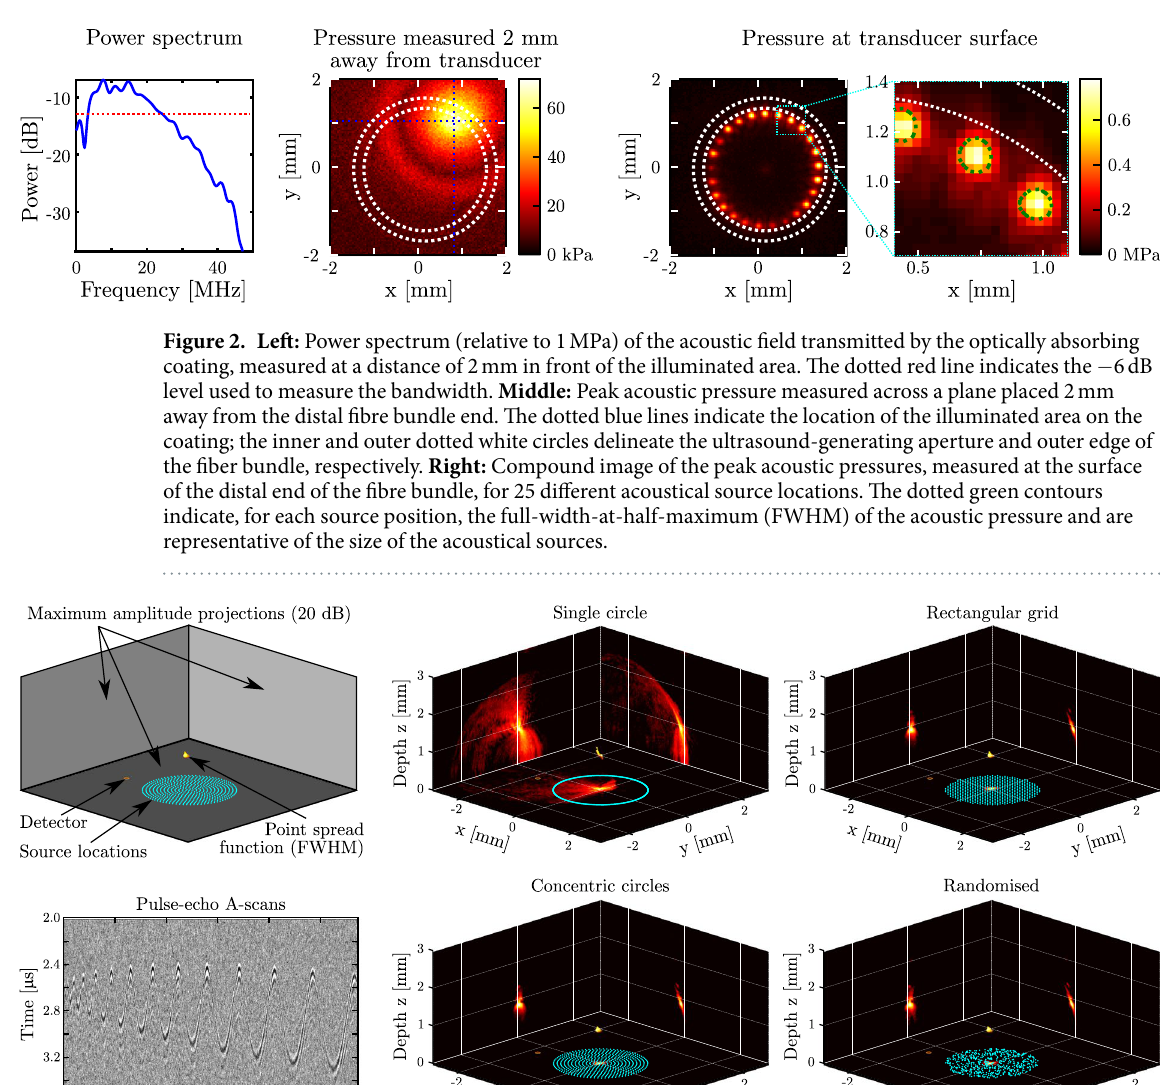
object depth of z = 0.9 mm and a source location pattern comprising concentric circles, the FWHM of the point spread function in the x , y and z directions measured 97 μ m, 179 μ m and 110 μ m, respectively. Similar FWHM values were found for all four patterns. These similarities were expected, given that the point spread function is primarily determined by the acoustic bandwidth, frequency, attenuation, and aperture size, which were identical for all four patterns. However, the point spread functions evaluated at the − 20 dB level varied strongly with the source location pattern. The discrepancy between the resolutions in the x and y directions were likely caused by a slight misalignment of the pushpin and surface roughness of its tip. Significantly lower artefact levels, and hence